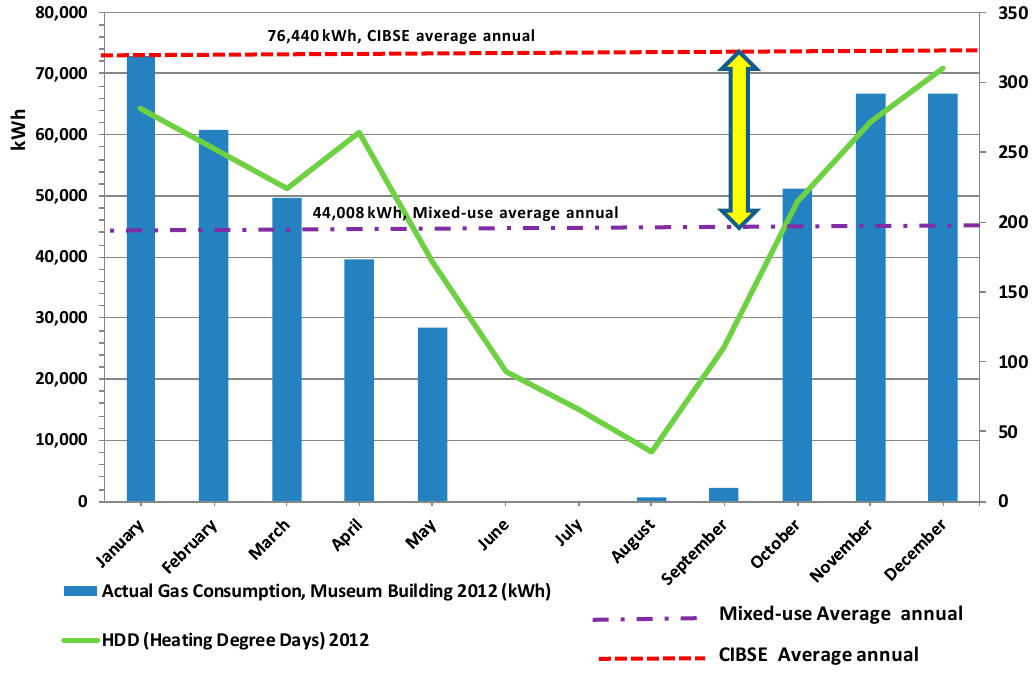
Figure 4. Comparison of actual heat consumption with CIBSE and mixed-use model. Table 4. Museum Building